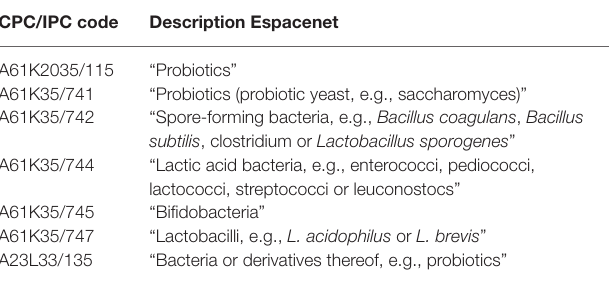
TABLE 1 | Overview of included patent classification